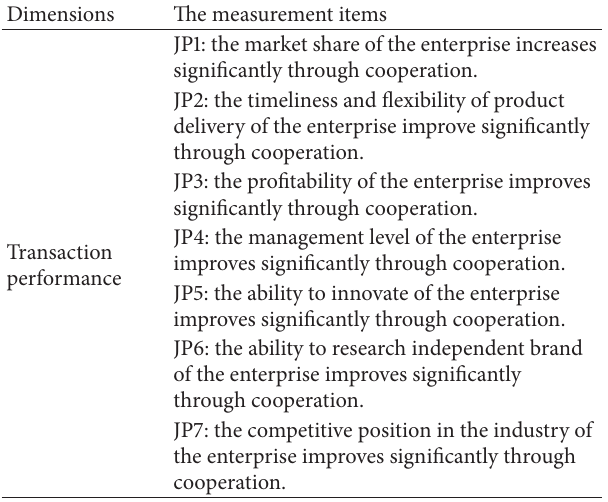
Table 4: The specific indexes of information sharing. Dimensions